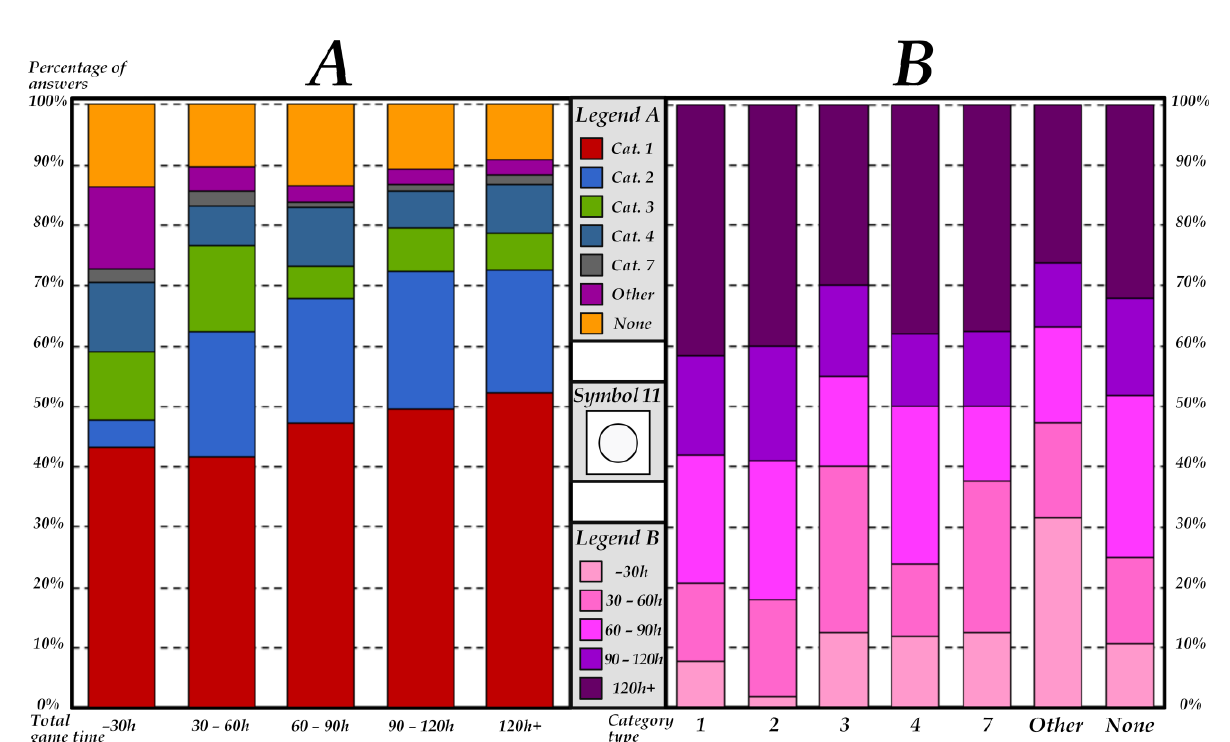
Figure 7. Cumulative charts presenting a percentage of individual categories of symbol 11 interpretation, divided according to the time spent on playing Valheim ( A ) and including individual groups (time spent on playing), divided according to interpretation categories ( B ).